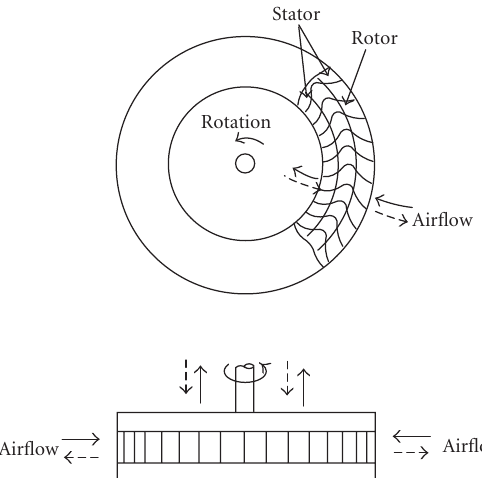
Figure 12: Radial turbine with fixed guide